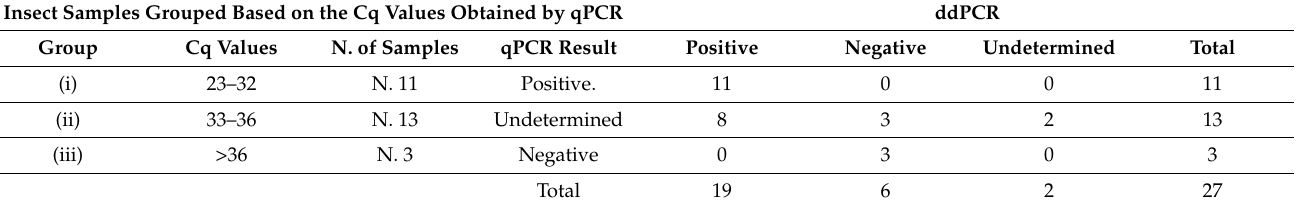
Table 6. Performance of ddPCR and qPCR assays for detection of Xfp in naturally infected insects. Insect samples were divided into two groups according to the Cq value obtained by